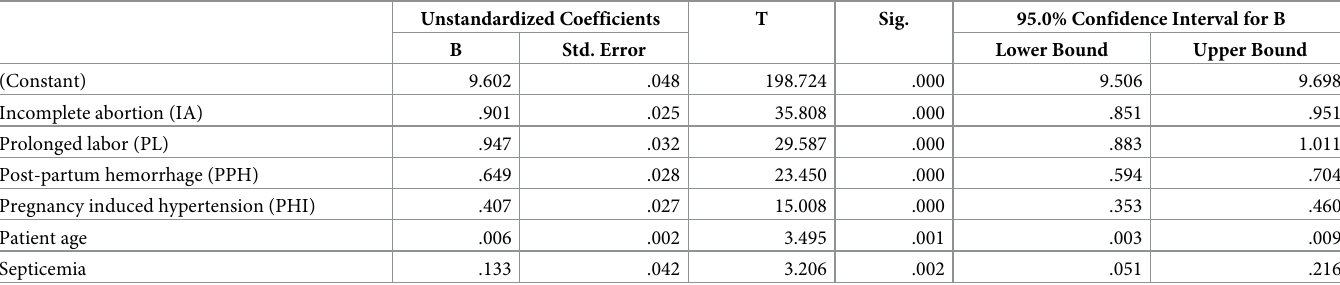
Table 5. Fitted direct medical cost model (n =